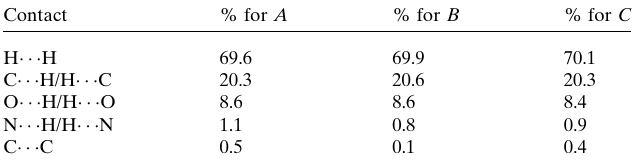
Table 2 Summary of short interatomic contacts (A˚ ) in the title compound. Contact Distance Symmetry operation